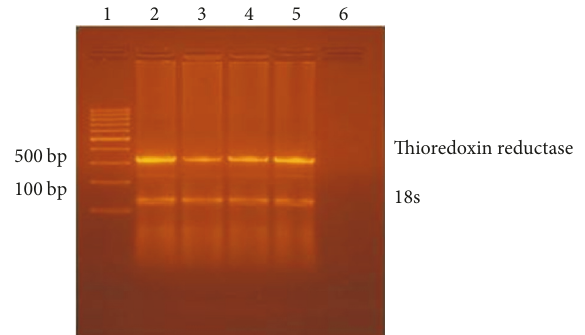
Figure 16: Agarose gel electrophoresis of RT-PCR products showed increase in the expression of TR genes in adrenal glands in tramadol withdrawal groups (groups III and IV) more than tramadol group (group